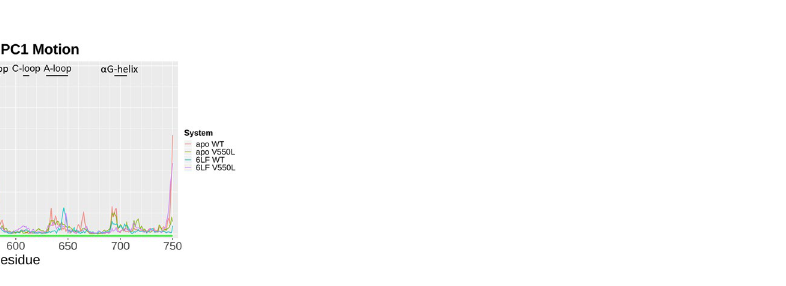
Figure 3. Residues’ contribution in the significant conformational motions. For each system, the 1st principal component motion was selected, and then the contribution of each residue in that motion was calculated.